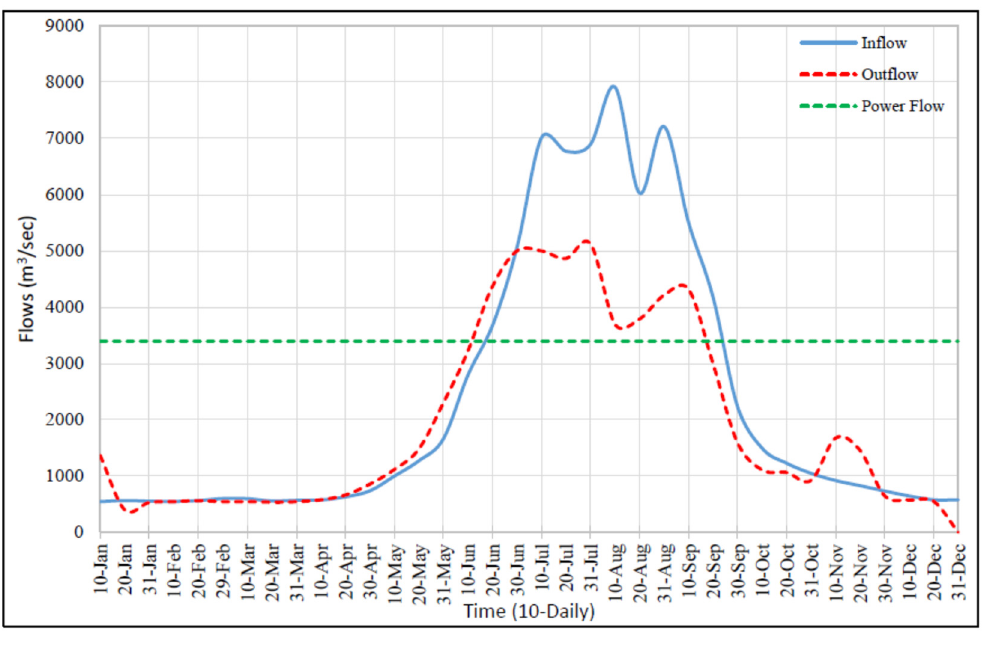
Figure 29. Inflow-Outflow Hydrograph of year 2009.